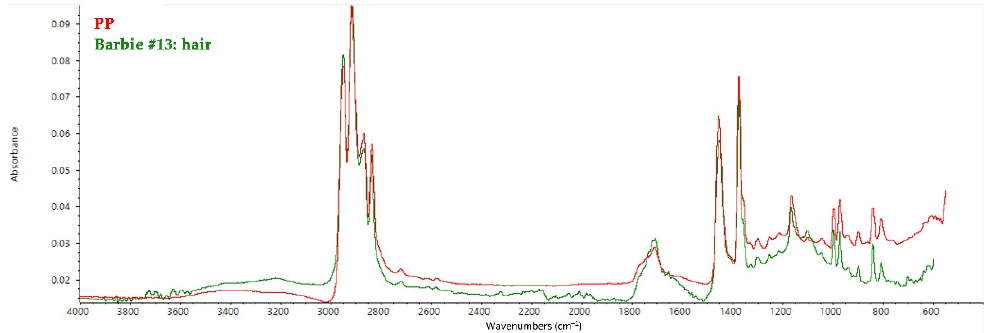
Figure 7. FT-IR ATR spectrum collected on the hair of Barbie #13 with the reference spectrum of PP.